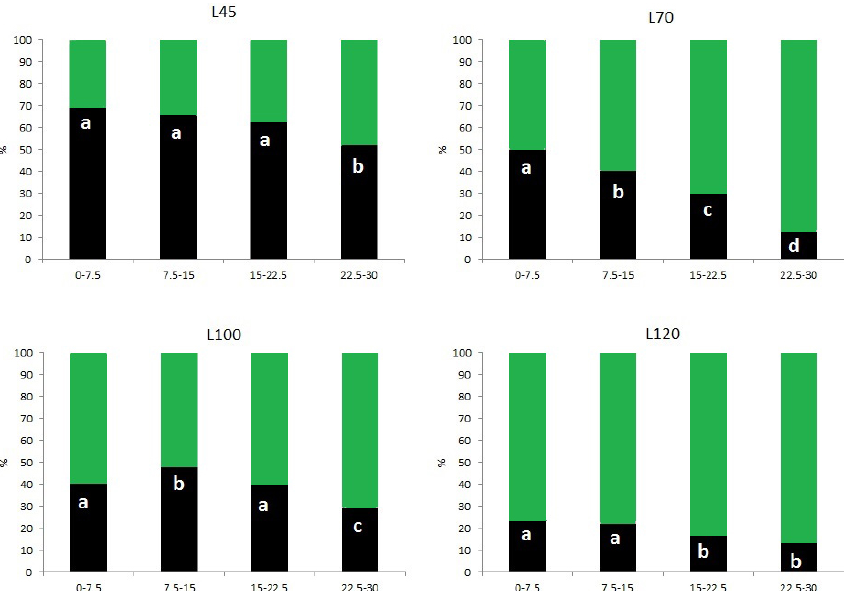
Figure 4. Contribution (%) of worm activity (black columns) and DOC (green columns) in C 3 -C portion at different soil depth. For each portion, different letters indicate differences for P ≤ 0 . 05.